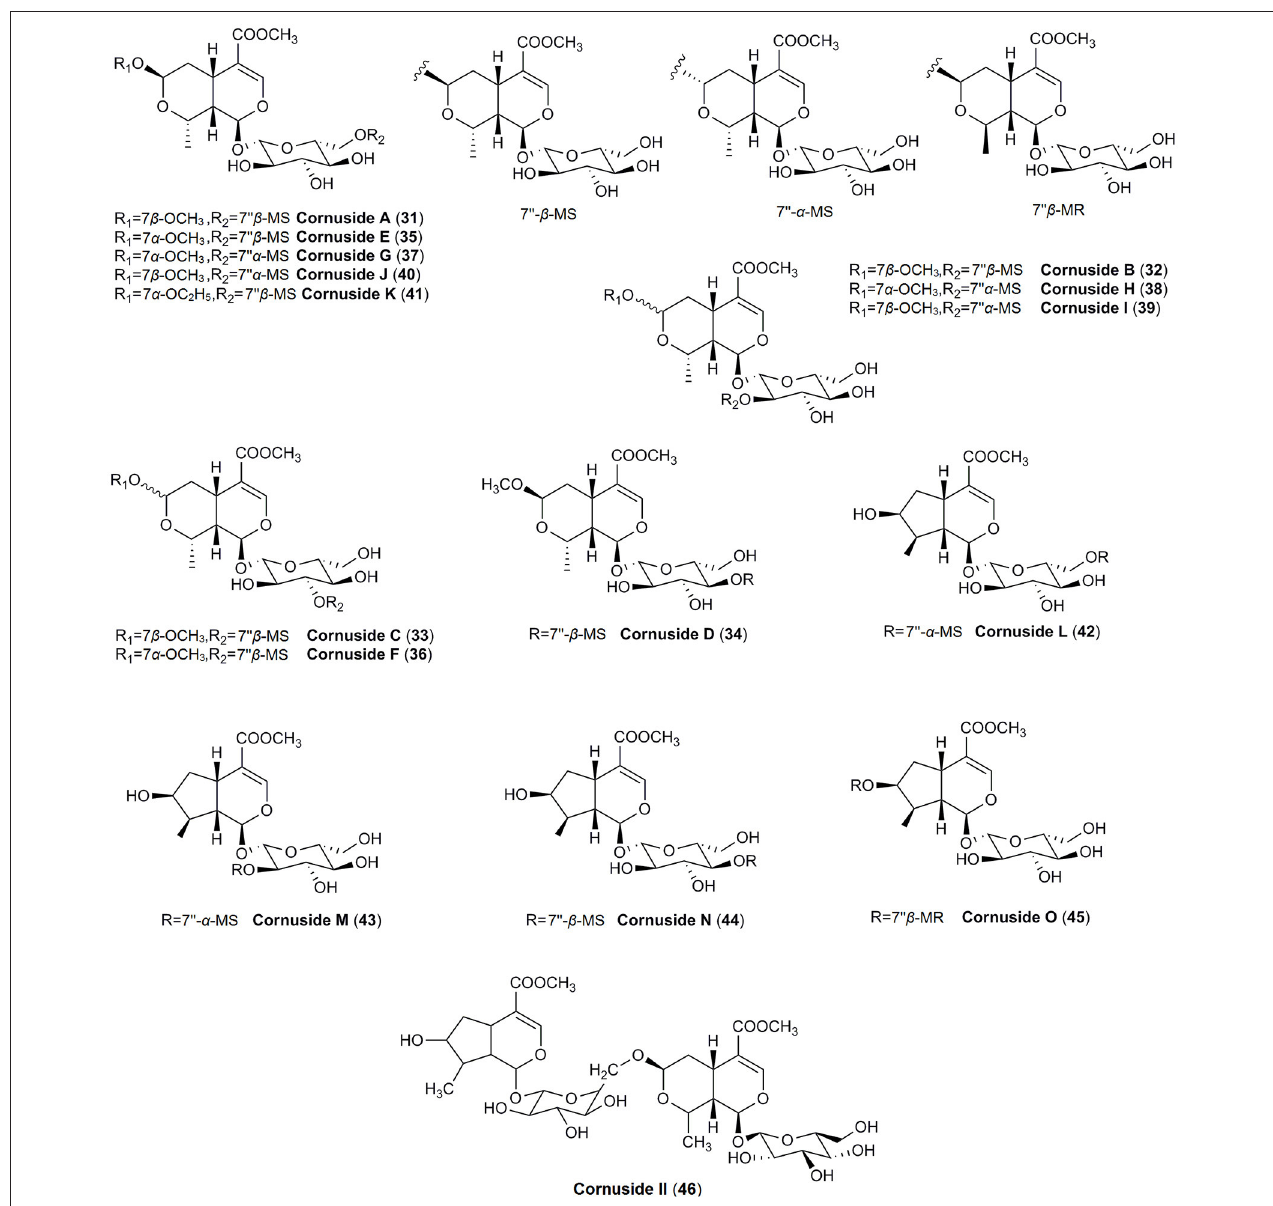
FIGURE 2 | The chemical structures of iridoids identified in fruits of C. officinalis